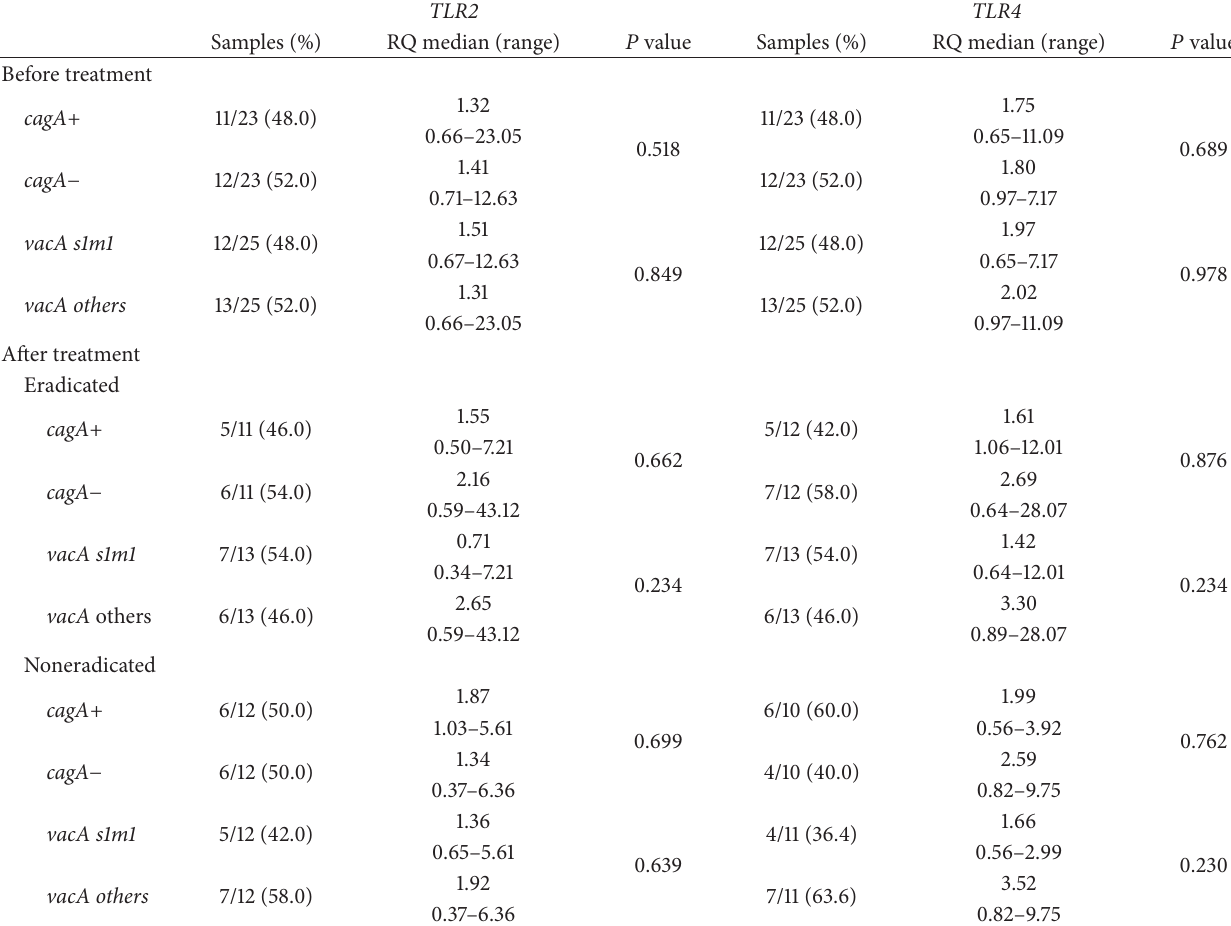
Table 3: Comparisons of TLR2 and TLR4 mRNA expression levels according to cagA and vacA genotypes of H. pylori in infected patients before and after bacteria eradication